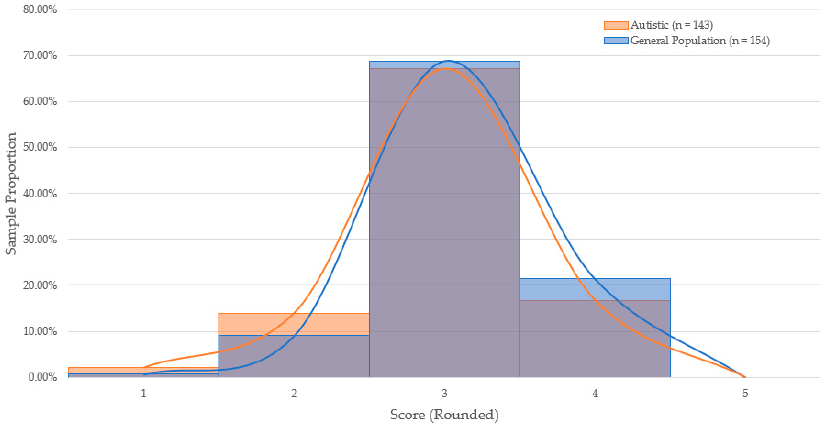
Figure 2. Distribution of Performance on Digitspan & Shapedance by Sample Proportion.